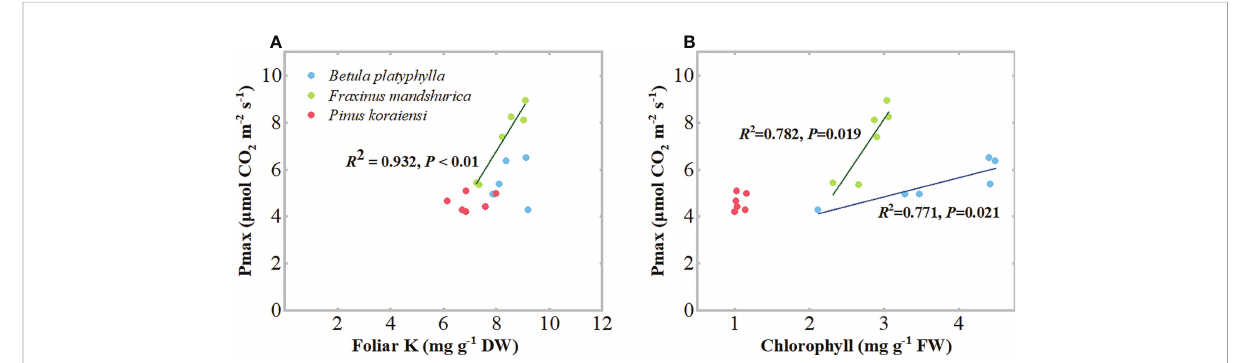
FIGURE 5 Leaf light-saturated net photosynthesis rate (Pmax, m mol CO 2 m -2 s -1 ) of three species affected by six canopy nitrogen (N) application treatments for 16 (A) and 32 (B) days. N application treatments included a control (no application of N) and fi ve types of N deposition with dry to wet ratios of 0:100 (0D+100W), 25:75 (25D+75W), 50:50 (50D+50W), 75:25 (75D+25W) and 100:0 (100D+0W), respectively. Error bars indicate the standard error of the mean ( n = 5). Within the same species in each panel, different letters on the left side of the error bar demonstrate signi fi cant differences among six treatments ( P < 0.05) according to the least signi fi cant difference